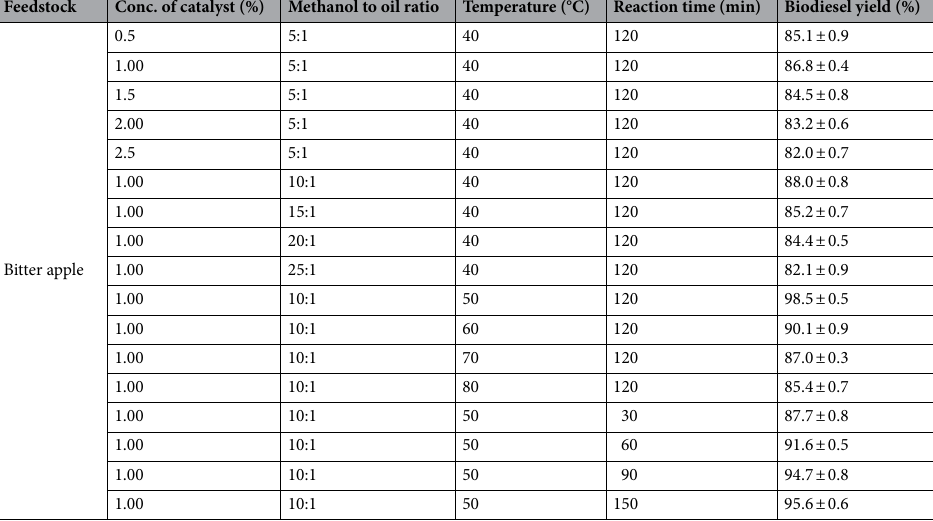
Table 6. Transesterification reaction parameters for bitter apple seed oil.